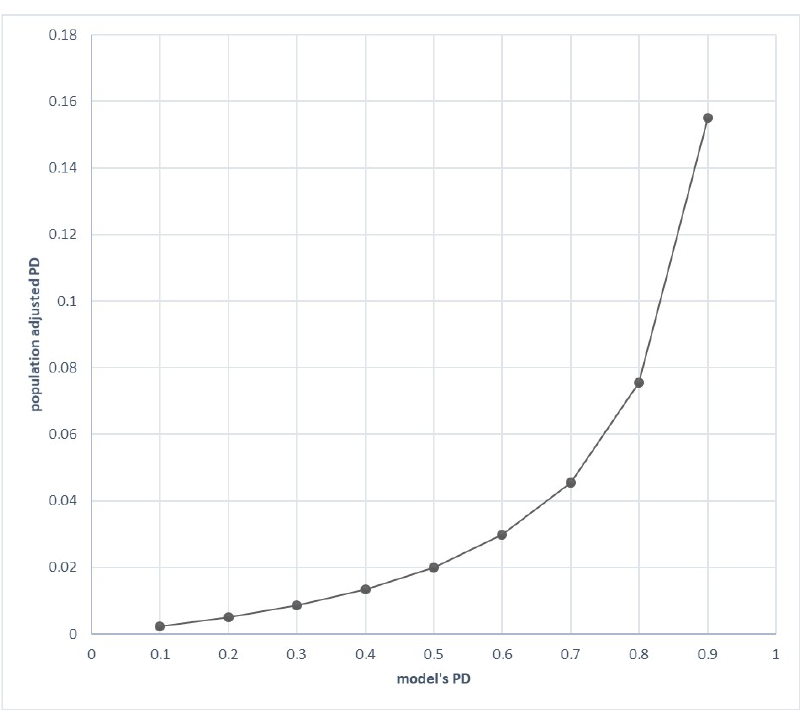
) ) for fail 𝑓𝑓𝑓𝑓𝑖𝑖𝑓𝑓𝑝𝑝𝑝𝑝𝑝𝑝𝑝𝑝 𝑝𝑝